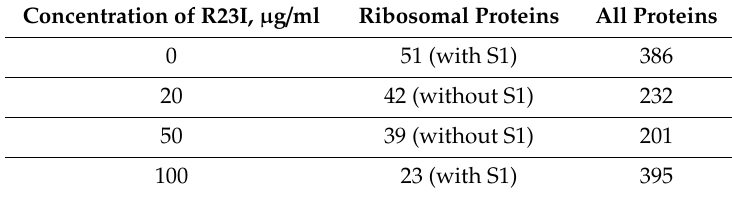
Table 3. Number of detected proteins with the number of identified peptides 3 or more in the studied samples